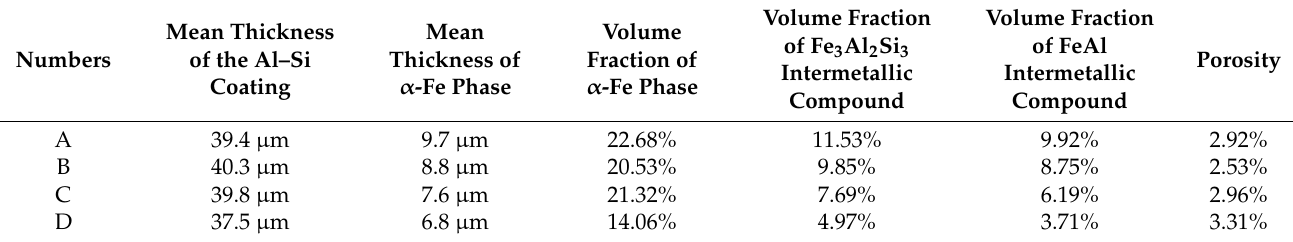
Table 5. Results of three-step heating